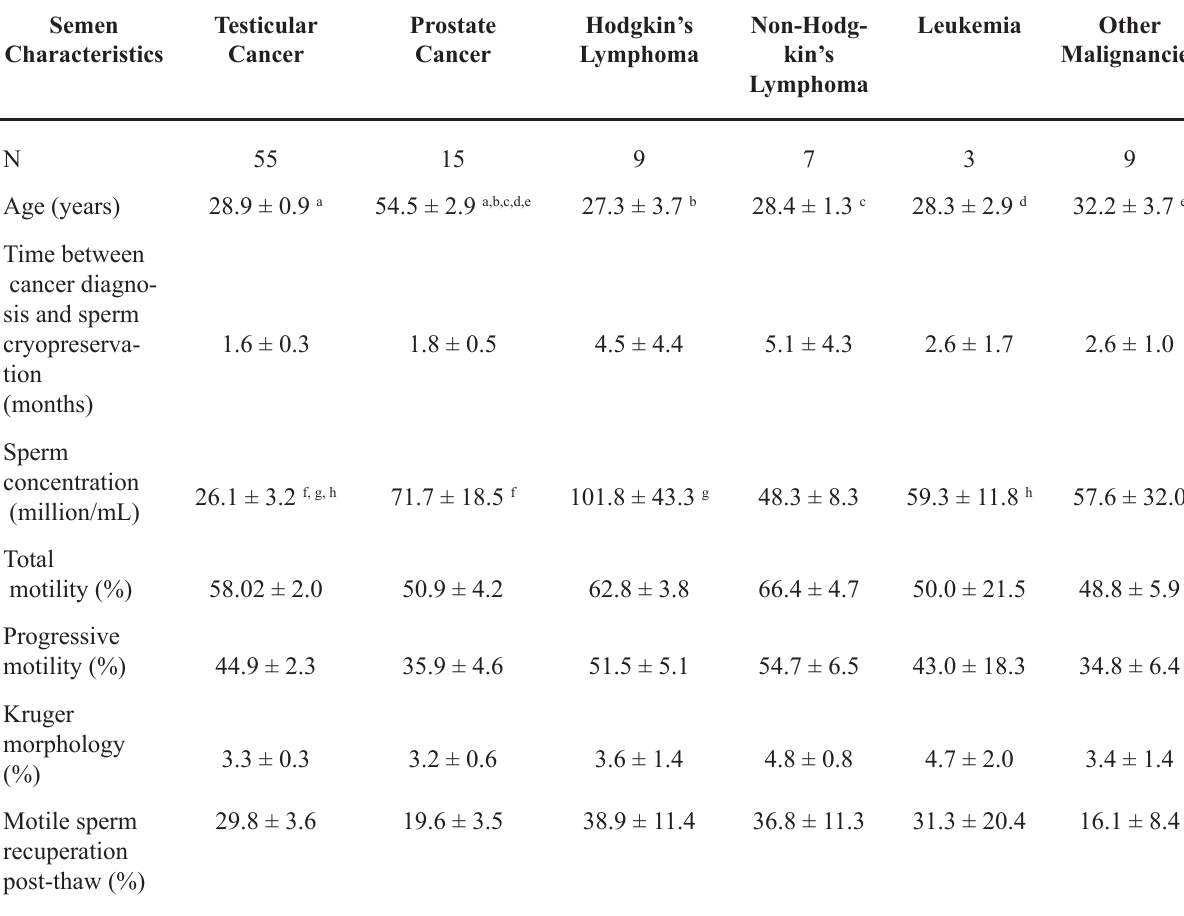
Table 1 – Semen characteristics among male cancer patients prior to therapeutic treatments.